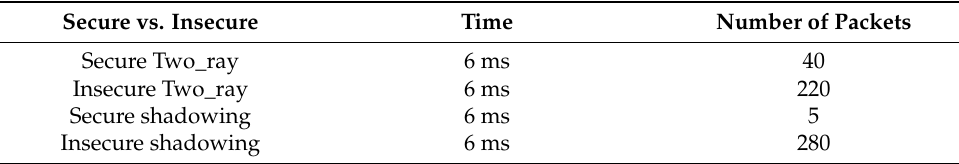
Figure 9. Routing Overhead of flying nodes in the network. Table 8. The number of packets versus time in routing overhead parameter.